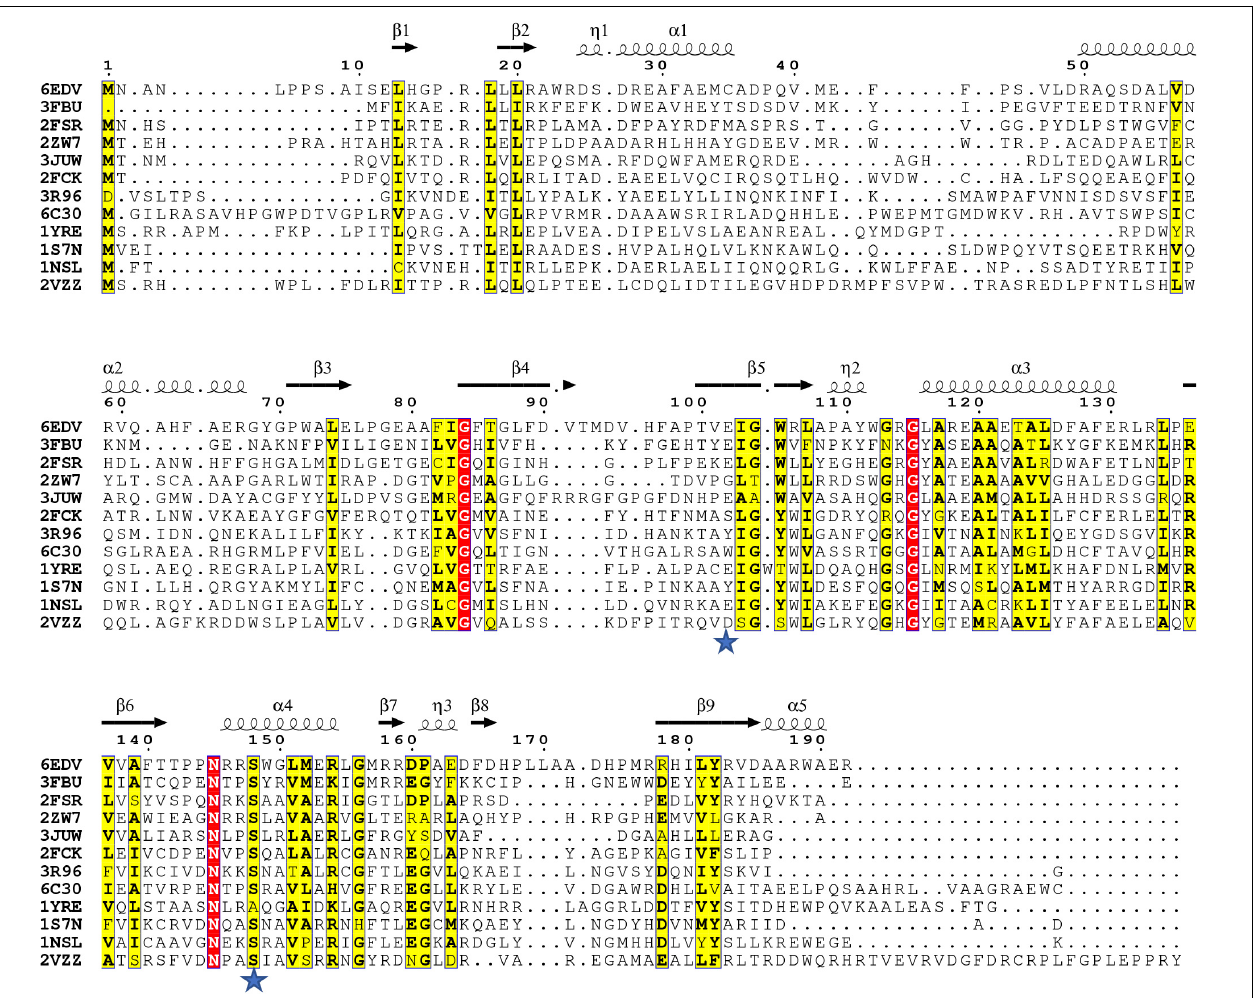
FIGURE 4 | Structure-based multiple sequence alignment of PA3944 and homologs. Residues boxed in red indicate strict conservation, while residues boxed in yellow indicate greater than or equal to 70% identity across the 11 homologs. Each homolog is identified by the PDB ID of the structure used to help align the sequences and further information about the identities of specific proteins is located in section “Materials and Methods.” Blue stars indicate location of PA3944 E102 and S148 residues characterized in this study. The figure was made using